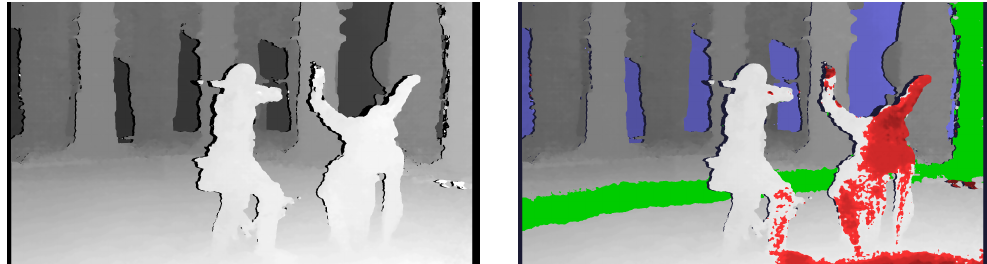
Figure 5. Calculated disparity map after image rectification—greyscale ( left ) and with depth budget constraints’ information ( right